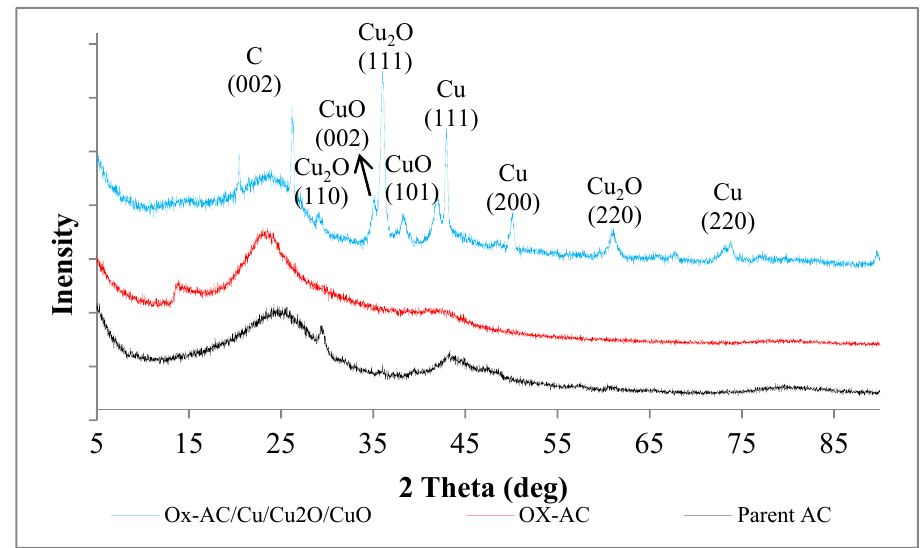
Figure 7. XRD patterns for parent AC, Ox-AC, Ox-AC/Cu/Cu 2 O/CuO.